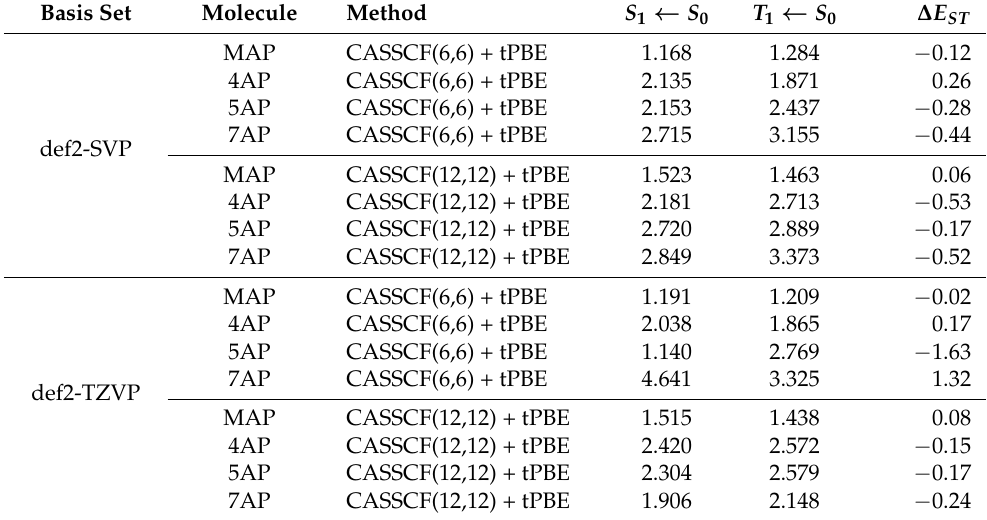
Table 3. Excited-state energies and associated ∆ E ST energy difference (all in eV) calculated with